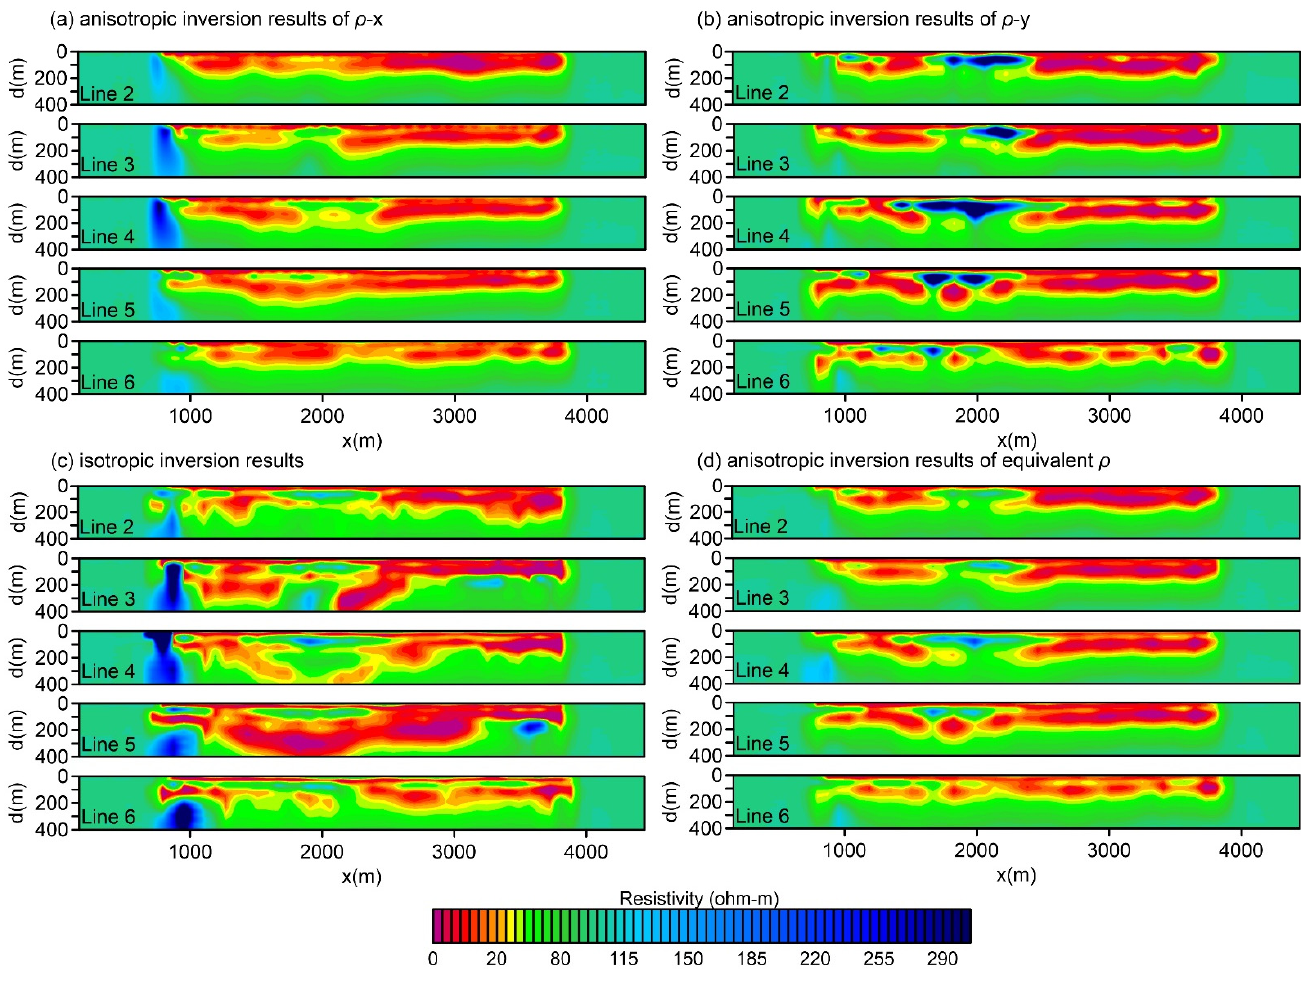
Figure 12. Comparison of anisotropic and isotropic inversions for the survey data acquired in Musgraves, South Australia. ( a ) and ( b ) show the inverted ρ x and ρ y of an anisotropic model; ( c ) shows the inverted resistivity of an isotropic model, while ( d ) shows the equivalent ρ h calculated from the anisotropic inversion results.